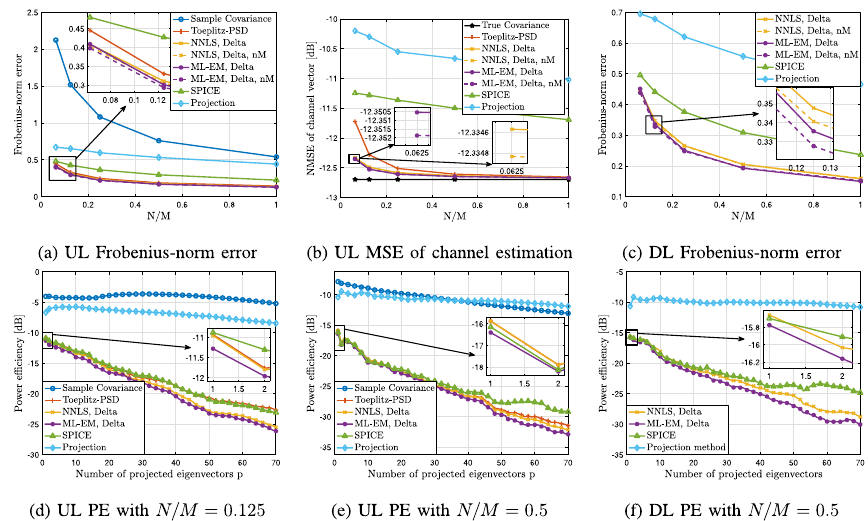
Fig. 7 Covariance estimation quality comparison for scenario